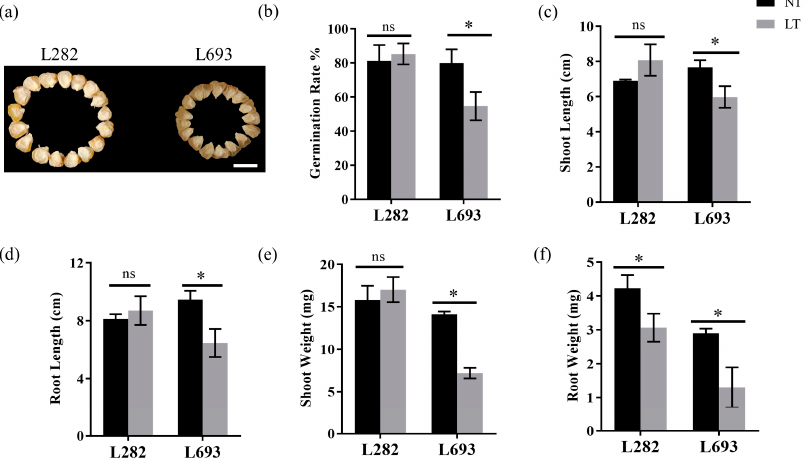
Figure 1. Characteristics of L282 and L693. ( a ) The mature dry seeds of the two lines, Bar = 1 cm; ( b – f ) comparisons of germination rate ( b ), shoot length ( c ), root length ( d ), shoot weight ( e ), and root weight ( f ) of the two lines germinated at normal temperature (NT) and low temperature (LT). The asterisks indicate significant difference at p < 0.05 (n = 3). The “ns” indicates no significant difference.